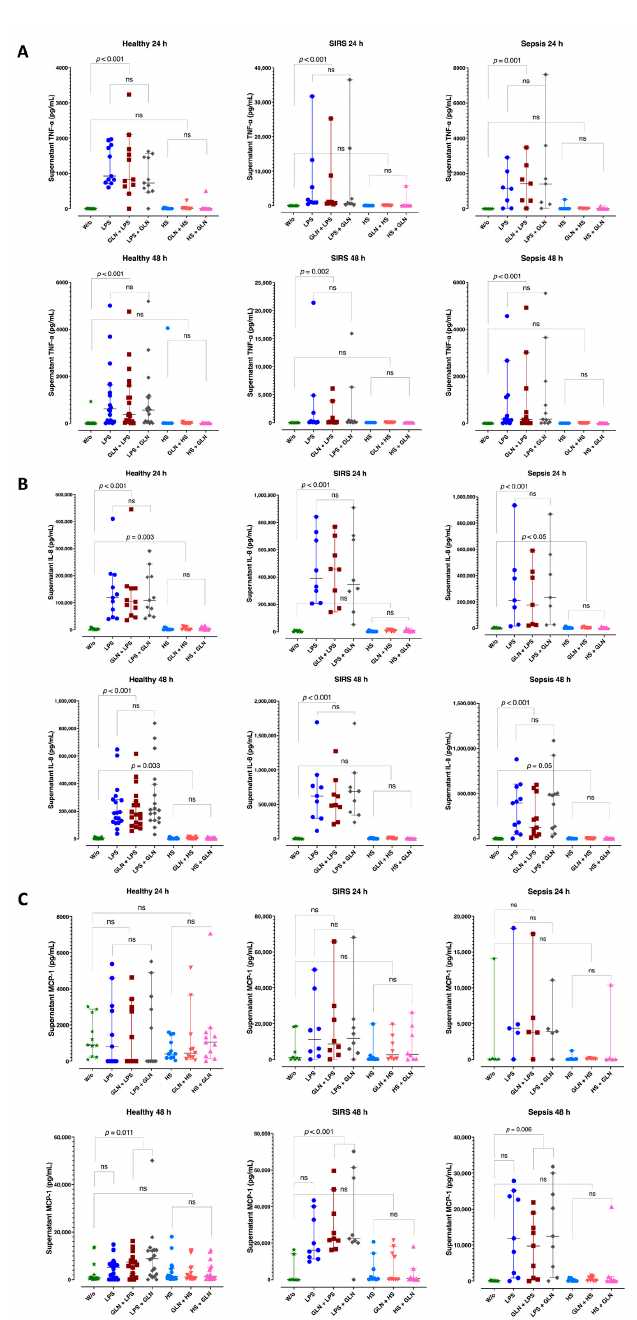
Figure 6. Supernatant TNF- α , IL-8, and MCP-1 at 24 and 48 h of LPS or HS stimulation. Before stimulation, supernatant cytokines did not differ among groups. ( A ) LPS induction increased the supernatant TNF- α concentrations at 24 and 48 h in all groups. HS did not induce TNF- α in any